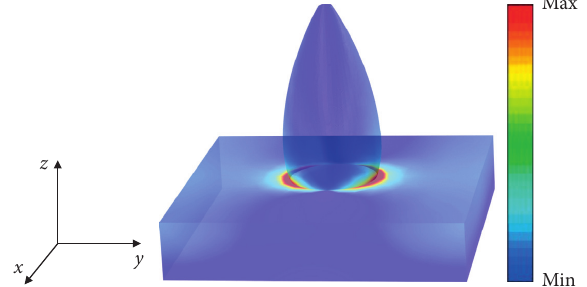
Figure 7: Field concentration in the CNV nanoantenna for normal incidence.